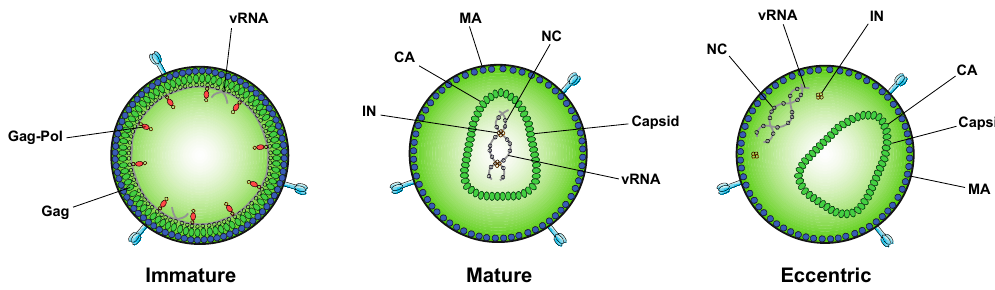
Figure 3. Inhibition of IN–RNA interactions result in the formation of eccentric virions. Immature viral particles consist of many molecules of Gag and Gag–Pol concentrically arranged along the inner leaflet of the viral membrane and bound to viral RNA (vRNA) at the NC domain. In mature viral particles, the vRNA is bound by NC and condensed with RT and IN to form the vRNP, which is enclosed in the conical capsid lattice made up of CA monomers. In eccentric viral particles, as observed upon inhibition of IN binding to the viral genome, the vRNP is mislocalized outside of the capsid lattice.